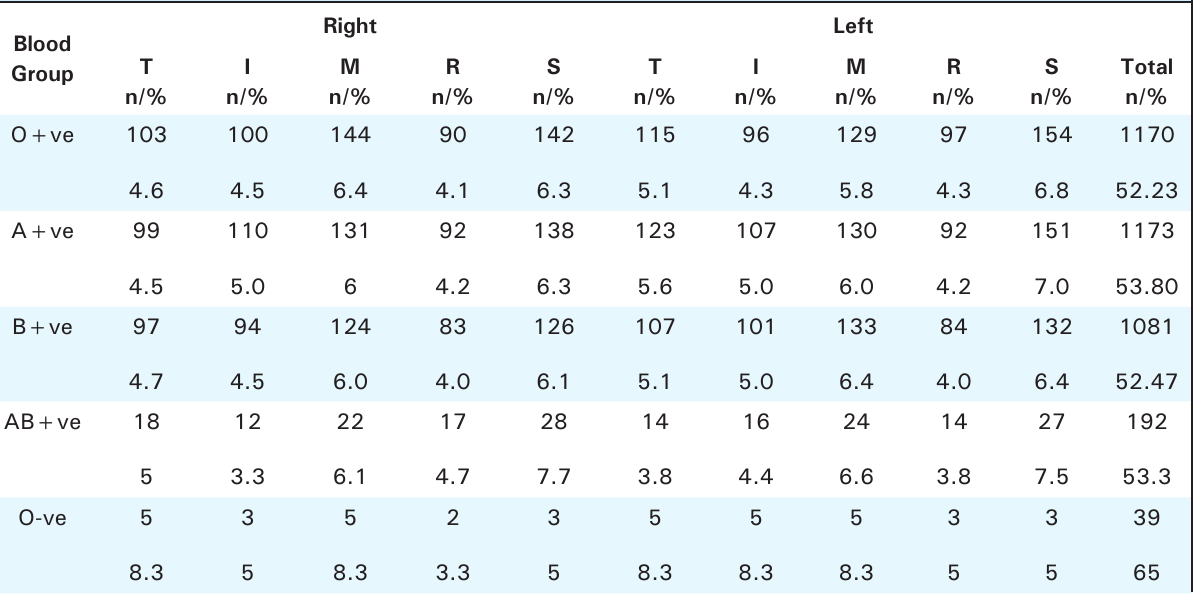
Table 3. Loop distribution and its mean comparison in individual fingers with the blood groups. Right Blood Group